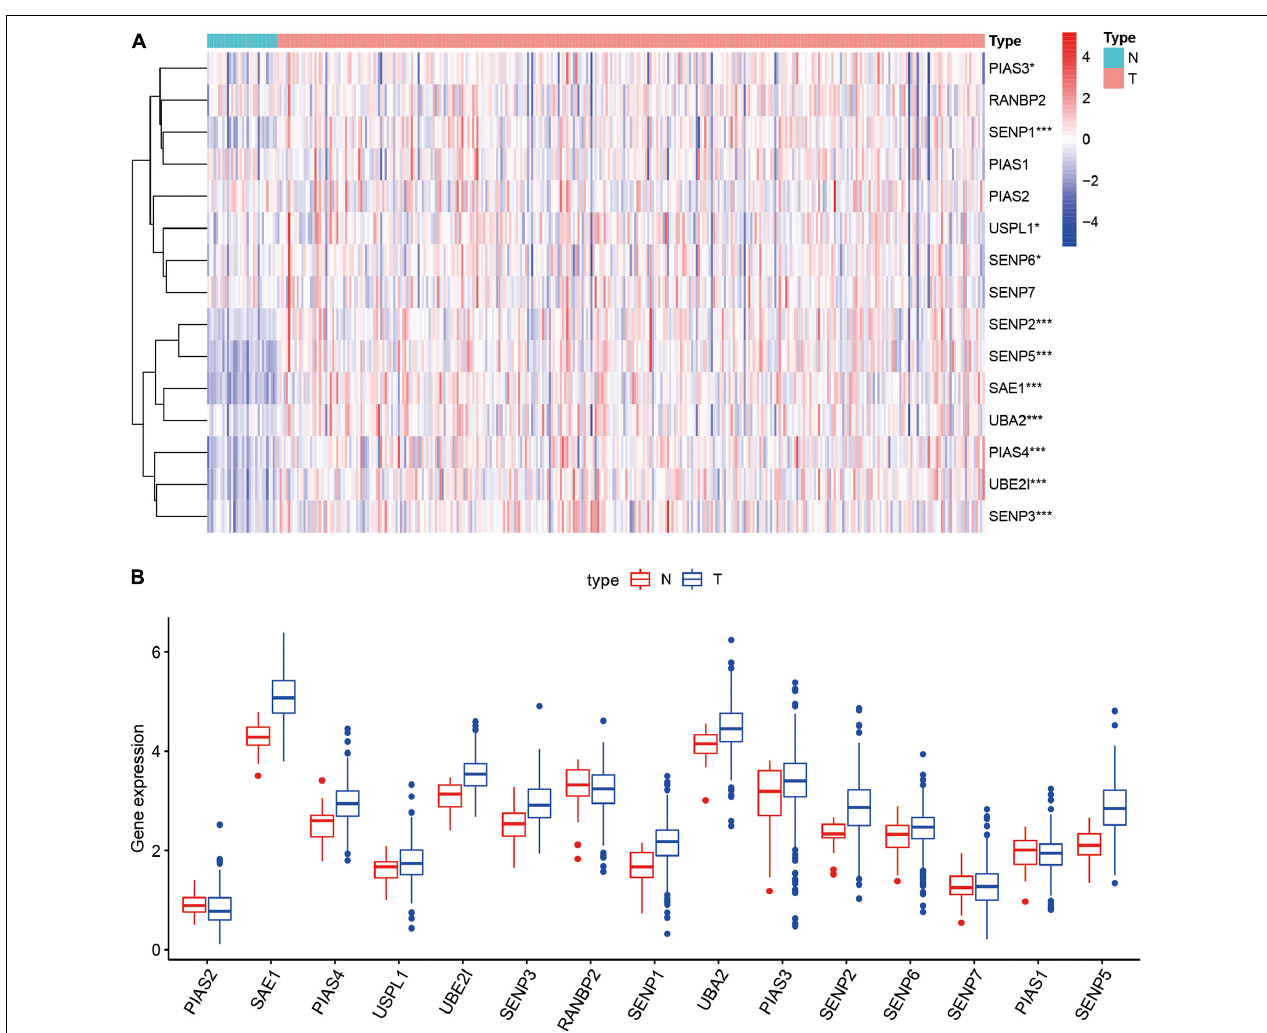
FIGURE 2 | Heatmap and boxplot of differential expression of SUMOylation regulators. (A) The heatmap of SUMOylation regulators. (B) The boxplot of SUMOylation